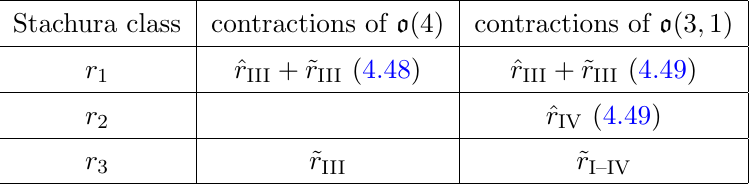
Table 2 . Comparison of our results from subsection 4.1{4.2 with the classi(cid:12)cation